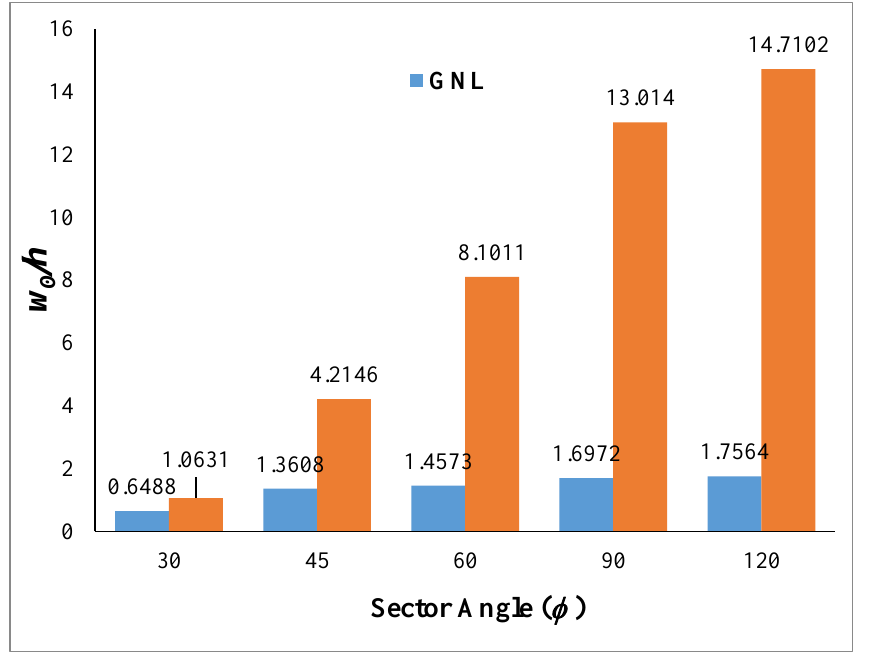
/ r = 3, b /h = 100, CCCC, f =30 Pa, b = 1m, ζ = 0.01). 2 1 1 0 1